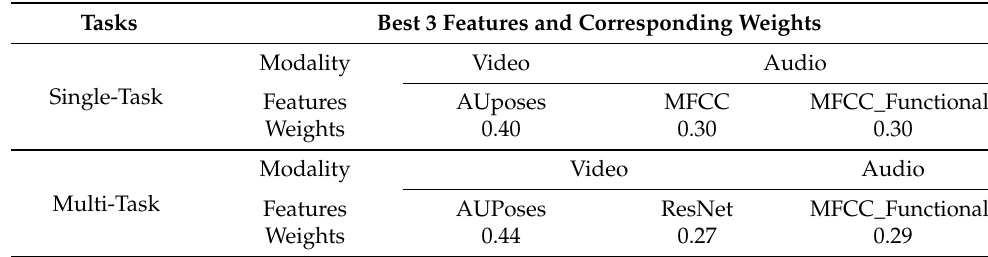
Table 5. The selection of modalities in TOP-3 Adaptive Late-Fusion and their corresponding weights. Tasks Best 3 Features and Corresponding Weights